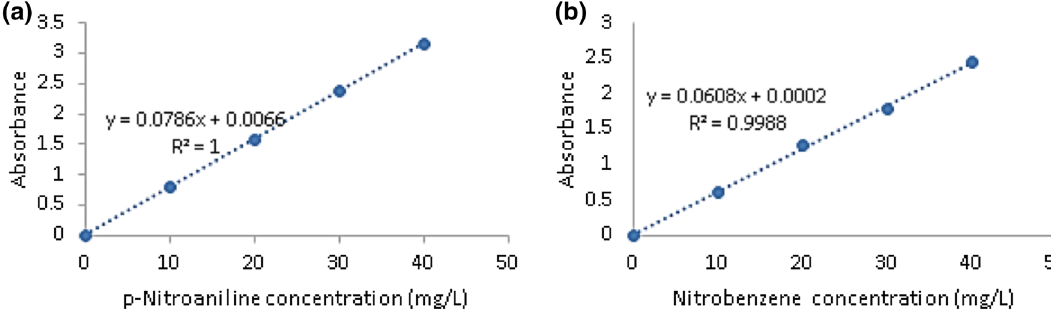
Fig. 1 Calibration plots for the measurement of a PNAN, b